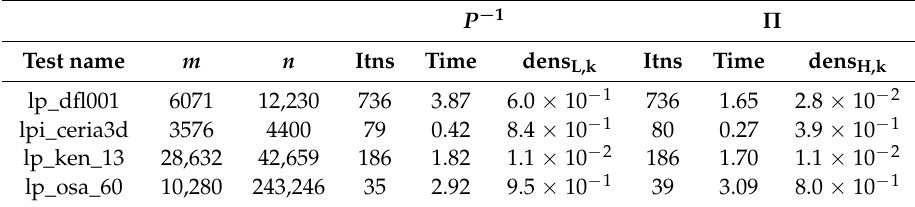
Table 1. Solution of systems with H = AA T , A ∈ IR m × n , using Partial Cholesky preconditioner and density of first k columns of L − 1 (dens L,k ), density of the first k columns of H (dens H,k